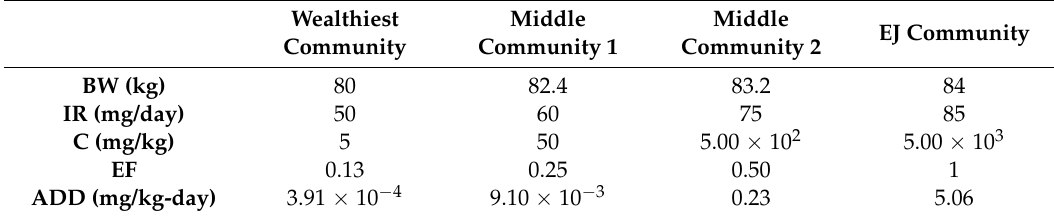
Table 1. Parameters and ADD Estimates for Four Different Scenarios. BW, body weight; IR, intake rate; C, lead concentration in soil; EF, exposure